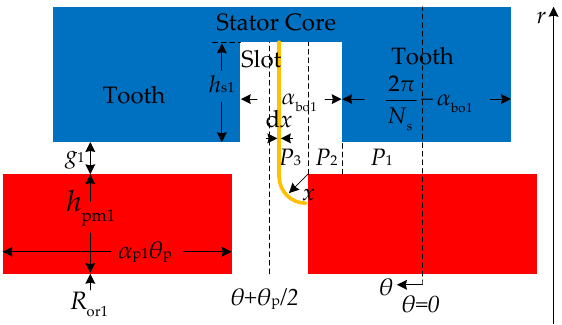
Figure 5. The inner air gap reluctance for cogging torque calculation.